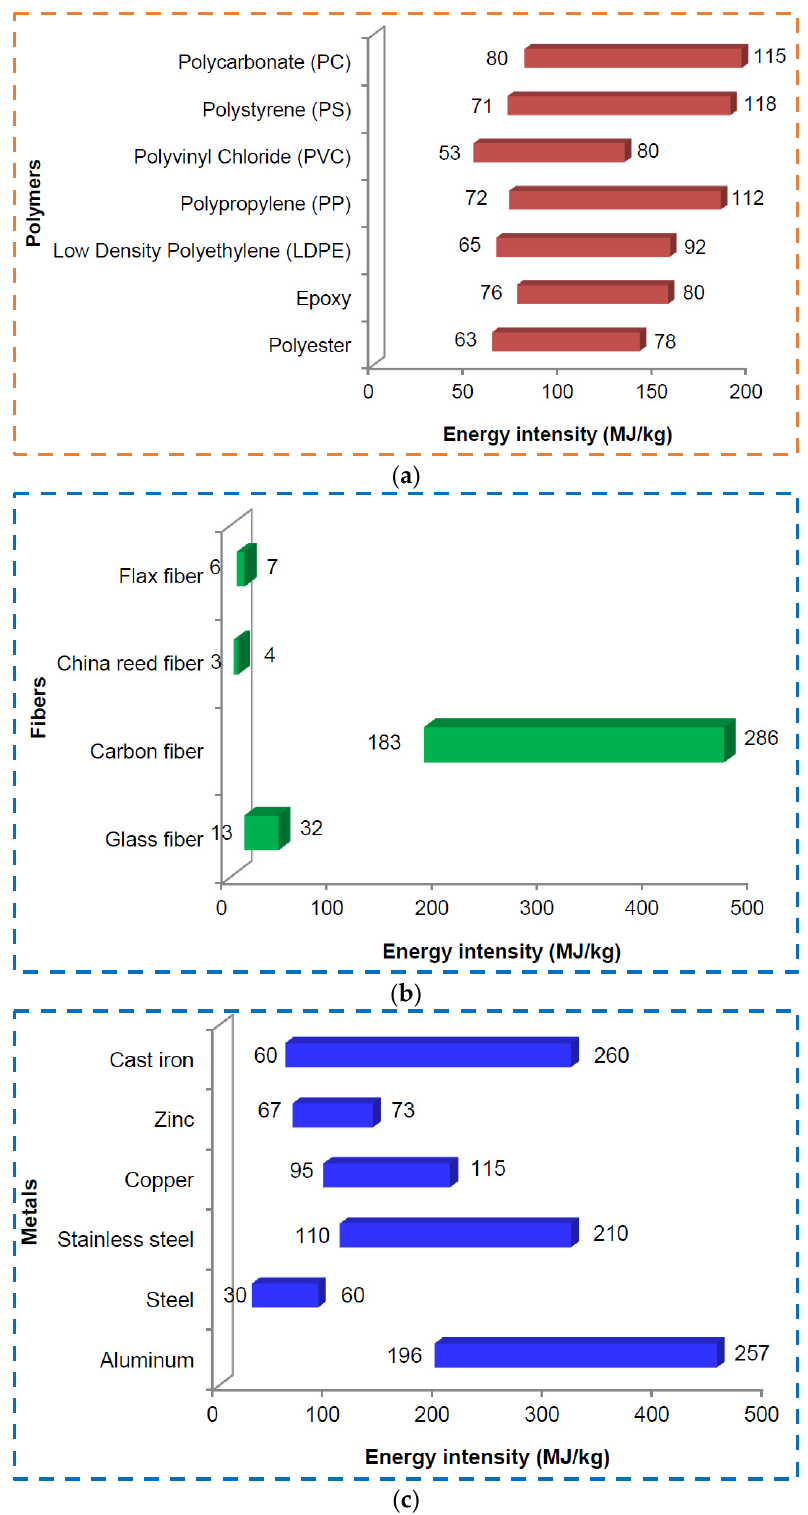
Figure 15. Energy intensity of various constituents used in development of composites [147]. ( a ) Polymers; ( b ) Fibers; ( c ) Metals. mers; ( b ) Fibers; ( c )